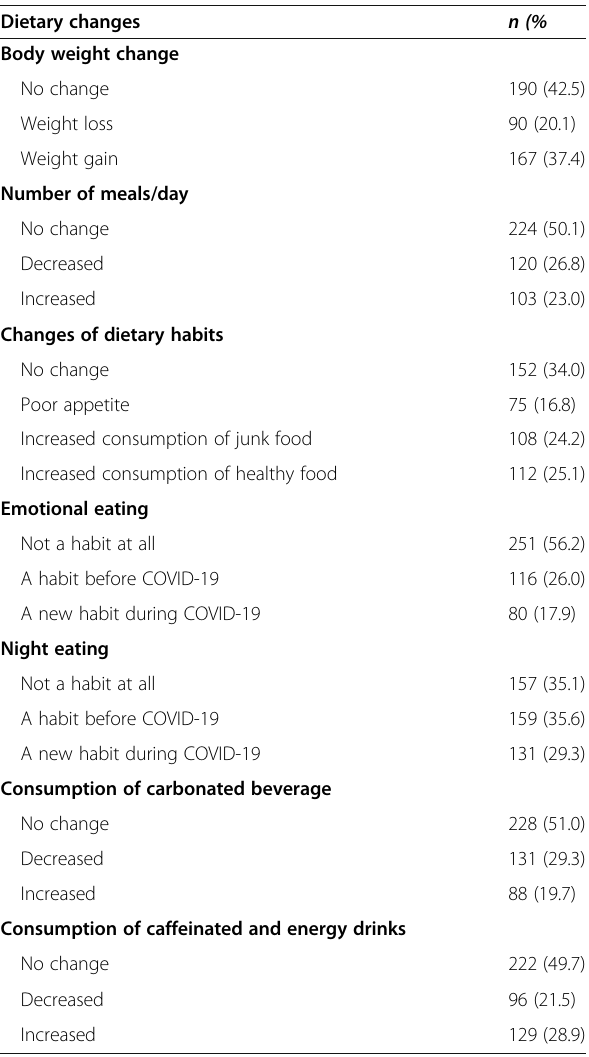
Table 2 Dietary changes among the study participants during COVID-19 pandemic ( n =